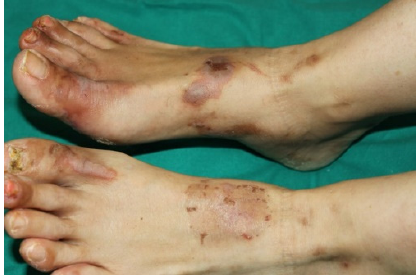
Figure 1. Necrolytic migratory erythema. Obligate paraneoplastic dermatosis associated with glucagonoma. Vesicles, erosions, crusts, and pustules arise at the periphery. The lesions enlarge in annular pattern, leaving pigmentation in the central area.